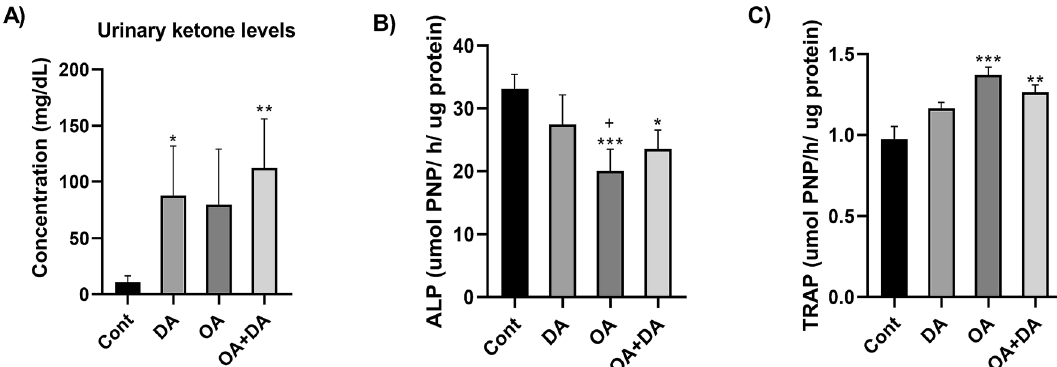
Figure 1. The figure shows the effects of decanoic acid, octanoic acid and their combination on the ( A ) ketone bodies detected on urine analysis, and biochemical estimation of ( B ) bone specific alkaline phosphatase (ALP) levels and ( C ) bone specific tartarate-resistant acid phosphatase (TRAP) levels in femur bones of mice. Values are represented as mean ± SD and analyzed by one-way ANOVA followed by Tukey Kramer multiple comparison test. The significance is ascertained as *** p < 0.001; ** p < 0.01; * p < 0.05 versus Cont; + p < 0.05 versus DA. Cont-Control; DA—Decanoic acid; OA—Octanoic